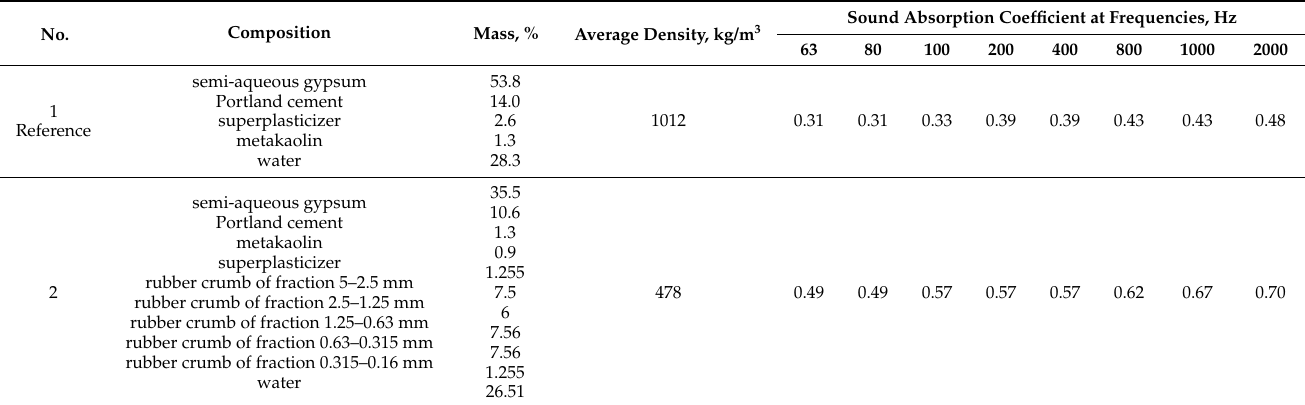
Table 5. Compositions and properties of material based on gypsum–cement–pozzolan